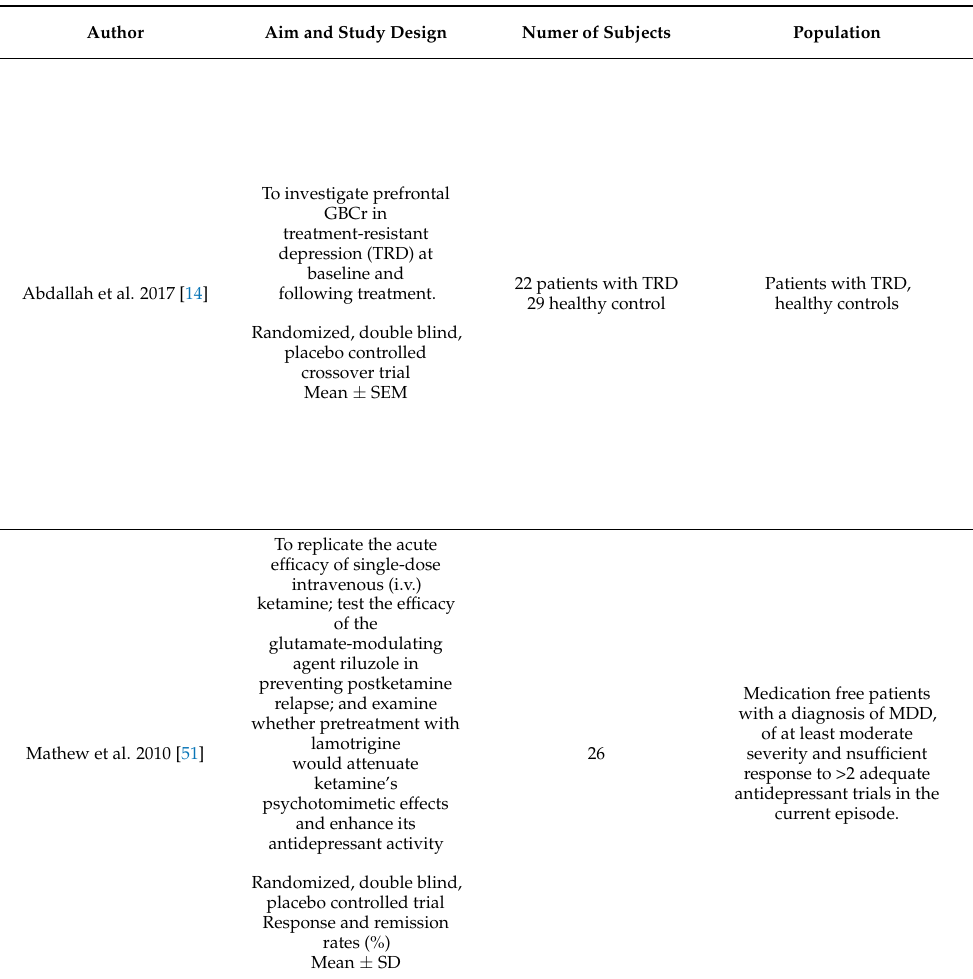
Table 3. Human studies in mood